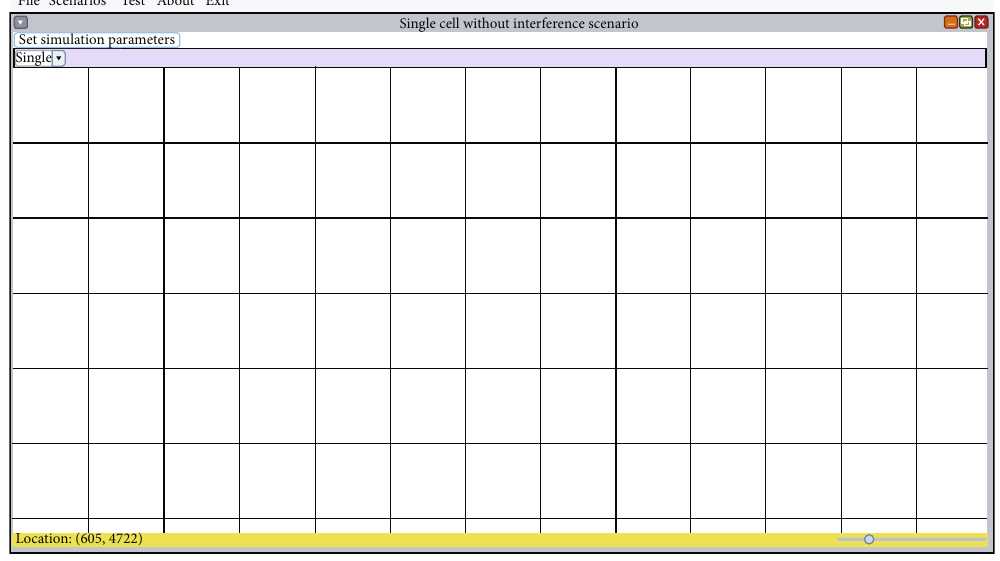
Figure 6: A workspace for single cell without